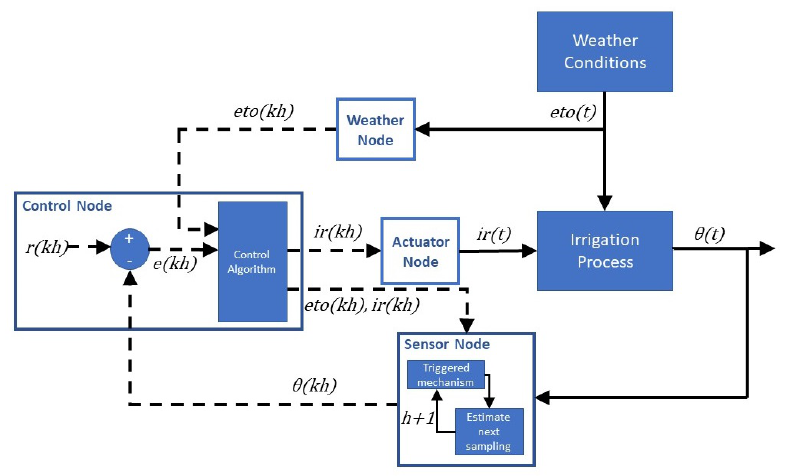
Figure 5. Precision irrigation control